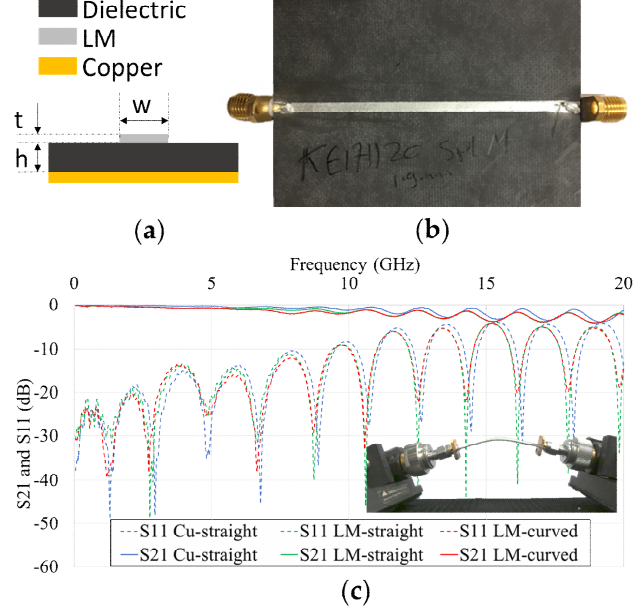
Figure 14. Sprayed-LM transmission line: ( a ) cross-section, ( b ) photo of the implemented sprayed-LM TL, and ( c ) measured insertion loss ( S 21 ) and return loss ( S 11 ) of a straight Cu TL and a straight and curved sprayed LM